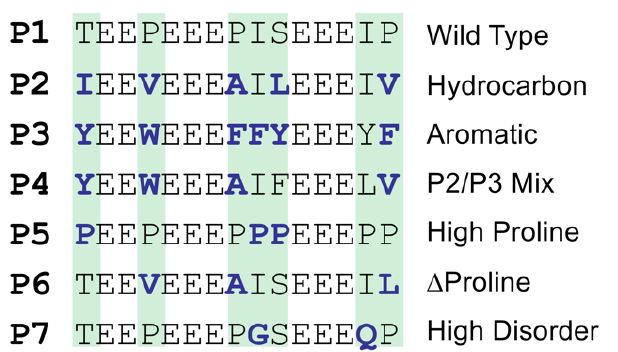
Figure 1. Sequences of the designed poly-E peptides. The reference sequence (P1) and the six variants are shown, with deviations from the reference highlighted in bold text.